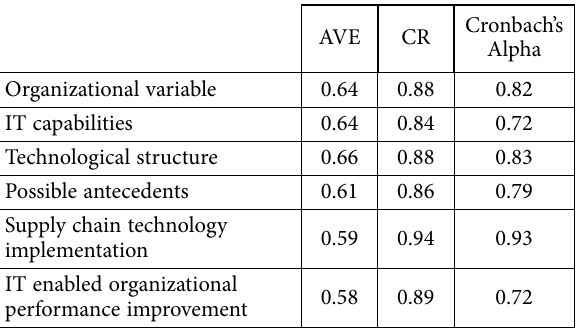
Table 2. Scale reliabilities and convergent